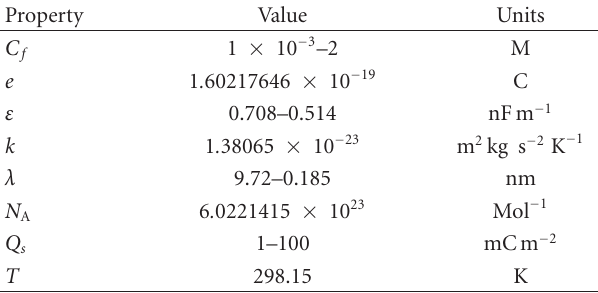
Table 2: Values of the properties used in the